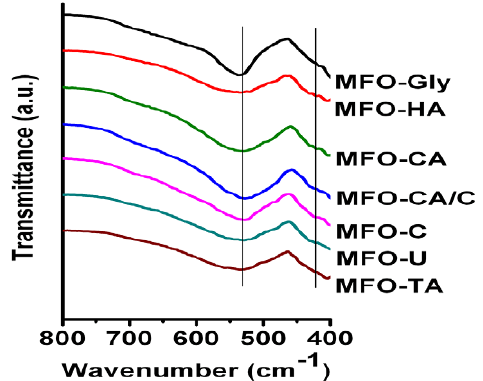
Figure 5. IR spectra of magnesium ferrite powder synthesized at 1173